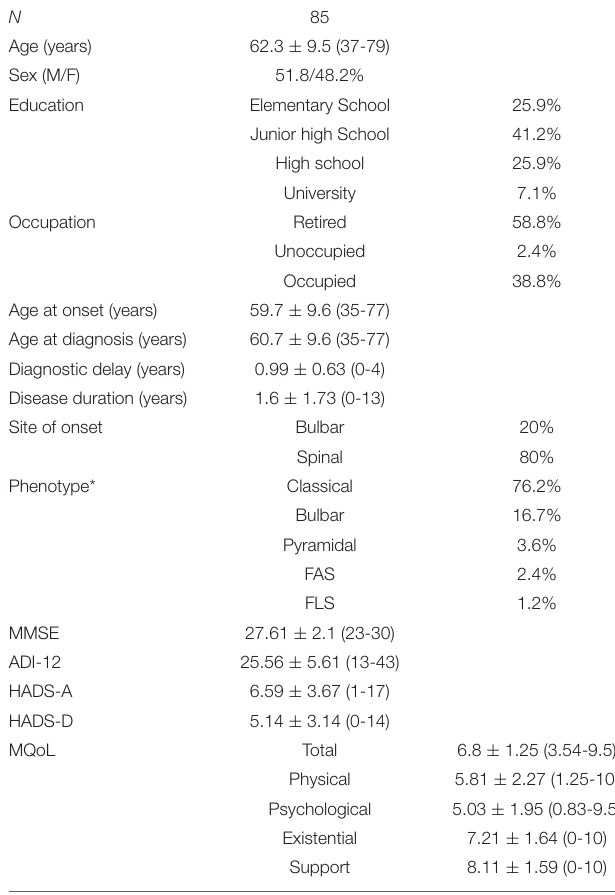
TABLE 1 | Patients’ background and clinical